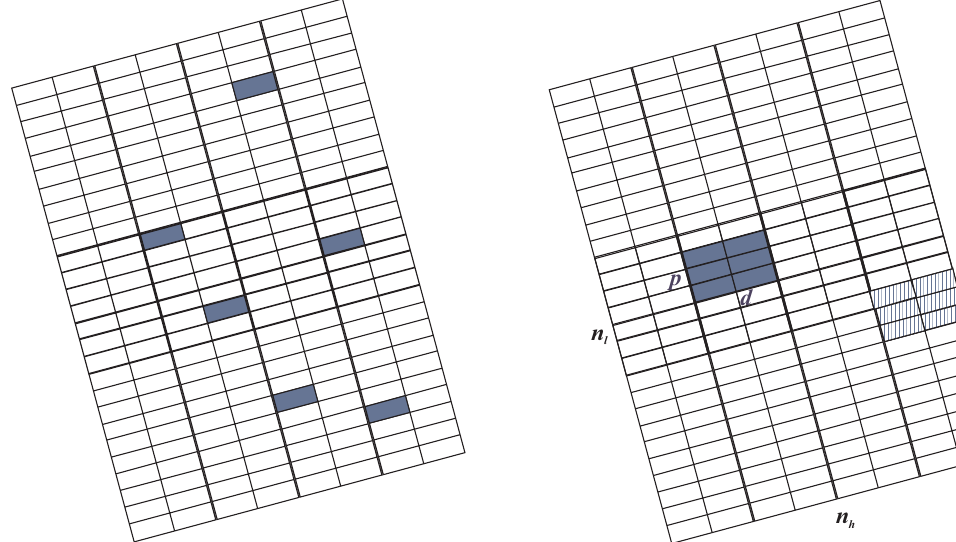
Figure 8. Random consolidated land tenure placement within a land